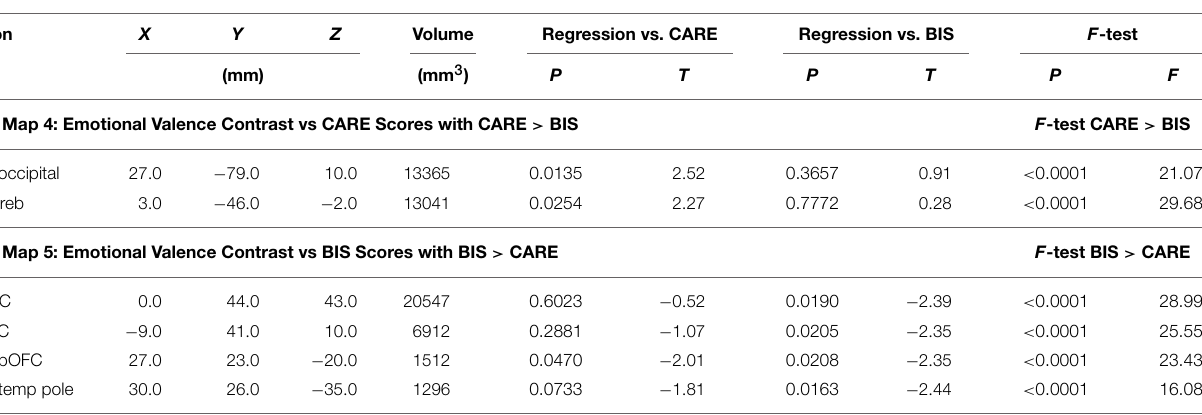
and pgACC regions did not overlap with the vmPFC region from Map 1. BIS scores accounted for significantly more variance in the emotional valence contrast values compared to CARE scores in all of these regions, as required by Map 5’s inclusion criteria (also see Table 4 ). Map 4 (regression of emotional valence con- trast vs. CARE scores) did not include significant clusters in these regions. In terms of regression of emotional valence contrast vs. CARE scores, the median across voxels in the right pOFC region from Map 5 did exhibit a significant inverse relationship between emotional valence contrast values and CARE scores ( p = 0 . 047, Table 4 ), but this region did not survive multiple comparison cor- rection (cluster mass thresholding, see Section 2.7) in the t-map calculation for Map 4. Measures of influence (Cook’s distance) were below 1 for all participants for all of the above regions (see Supplementary Table 1). Correlation analyses revealed significant relationships between emotional valence contrast and several BIS subscales in these regions (see Supplementary Table